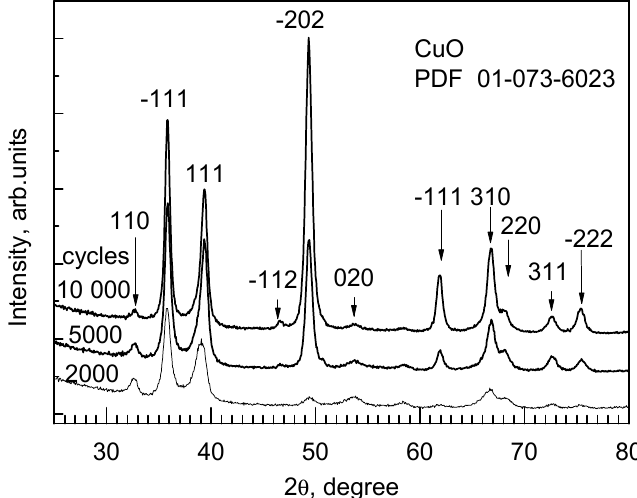
Figure 3. Representative X-ray diffraction patterns of CuO thin films grown on SiO 2 /Si substrate by using different number of deposition cycles indicated by labels.